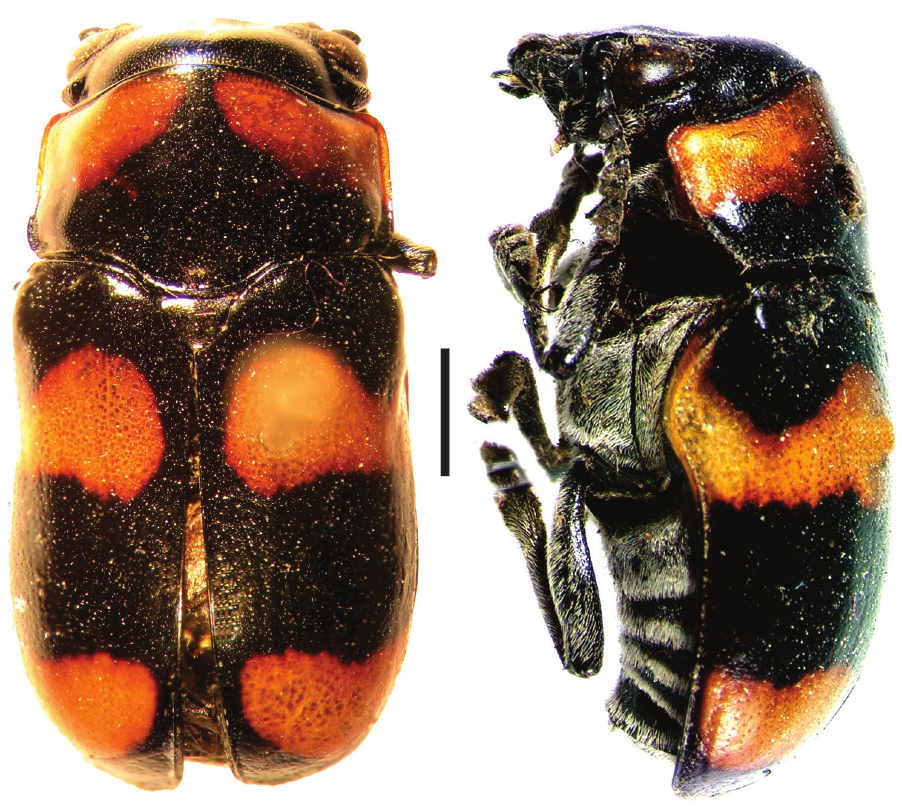
Figure 19. Megalostomis grossa (Forsberg) (1) , left: habitus (dorsal view), right: habitus (lateral view). = Megalostomis ( Scaphigenia ) Lacordaire 1848: 547; Chapuis 1874: 137; Jacoby and Clavareau 1906: 60; Clavareau 1913: 75; Achard 1926: 148; Guérin 1943: 24; Monrós 1953a: 88; Seeno and Wilcox 1982: 33; Agrain et al. 2007: 340; Agrain and Roig-Juñent 2011: 672, 695 (SYN). = Megalostomis ( Pygidiocarina ) Moldenke 1970: 26, 1981: 83; Agrain and Roig- Juñent 2011: 672, 695 (SYN). = Megalostomis ( Coleobyersa ) Moldenke 1981: 101; Agrain and Roig-Juñent 2011: 672, 695 (SYN). 672, 695